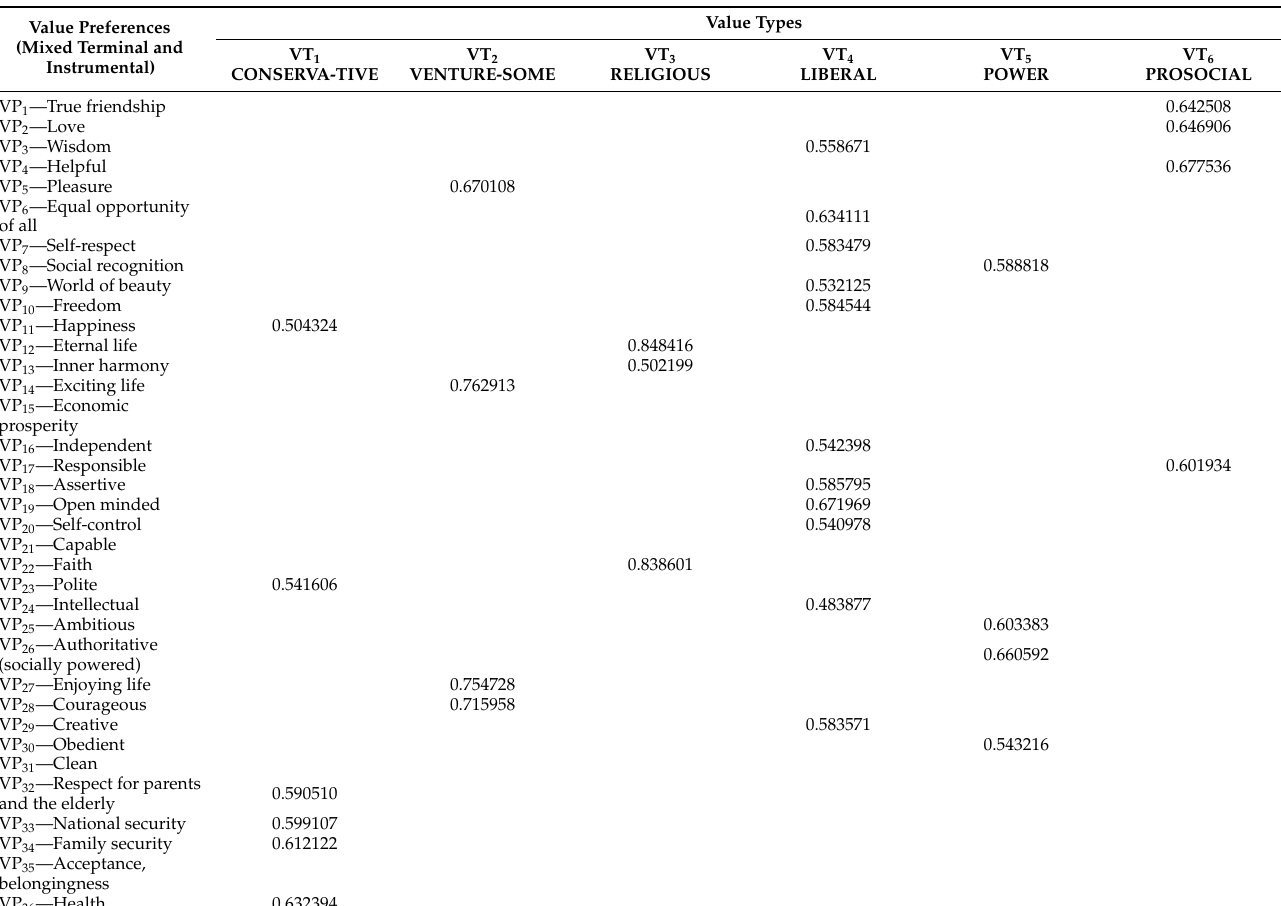
Table 4. Values factor analysis and factor loads ≥ 0.48.